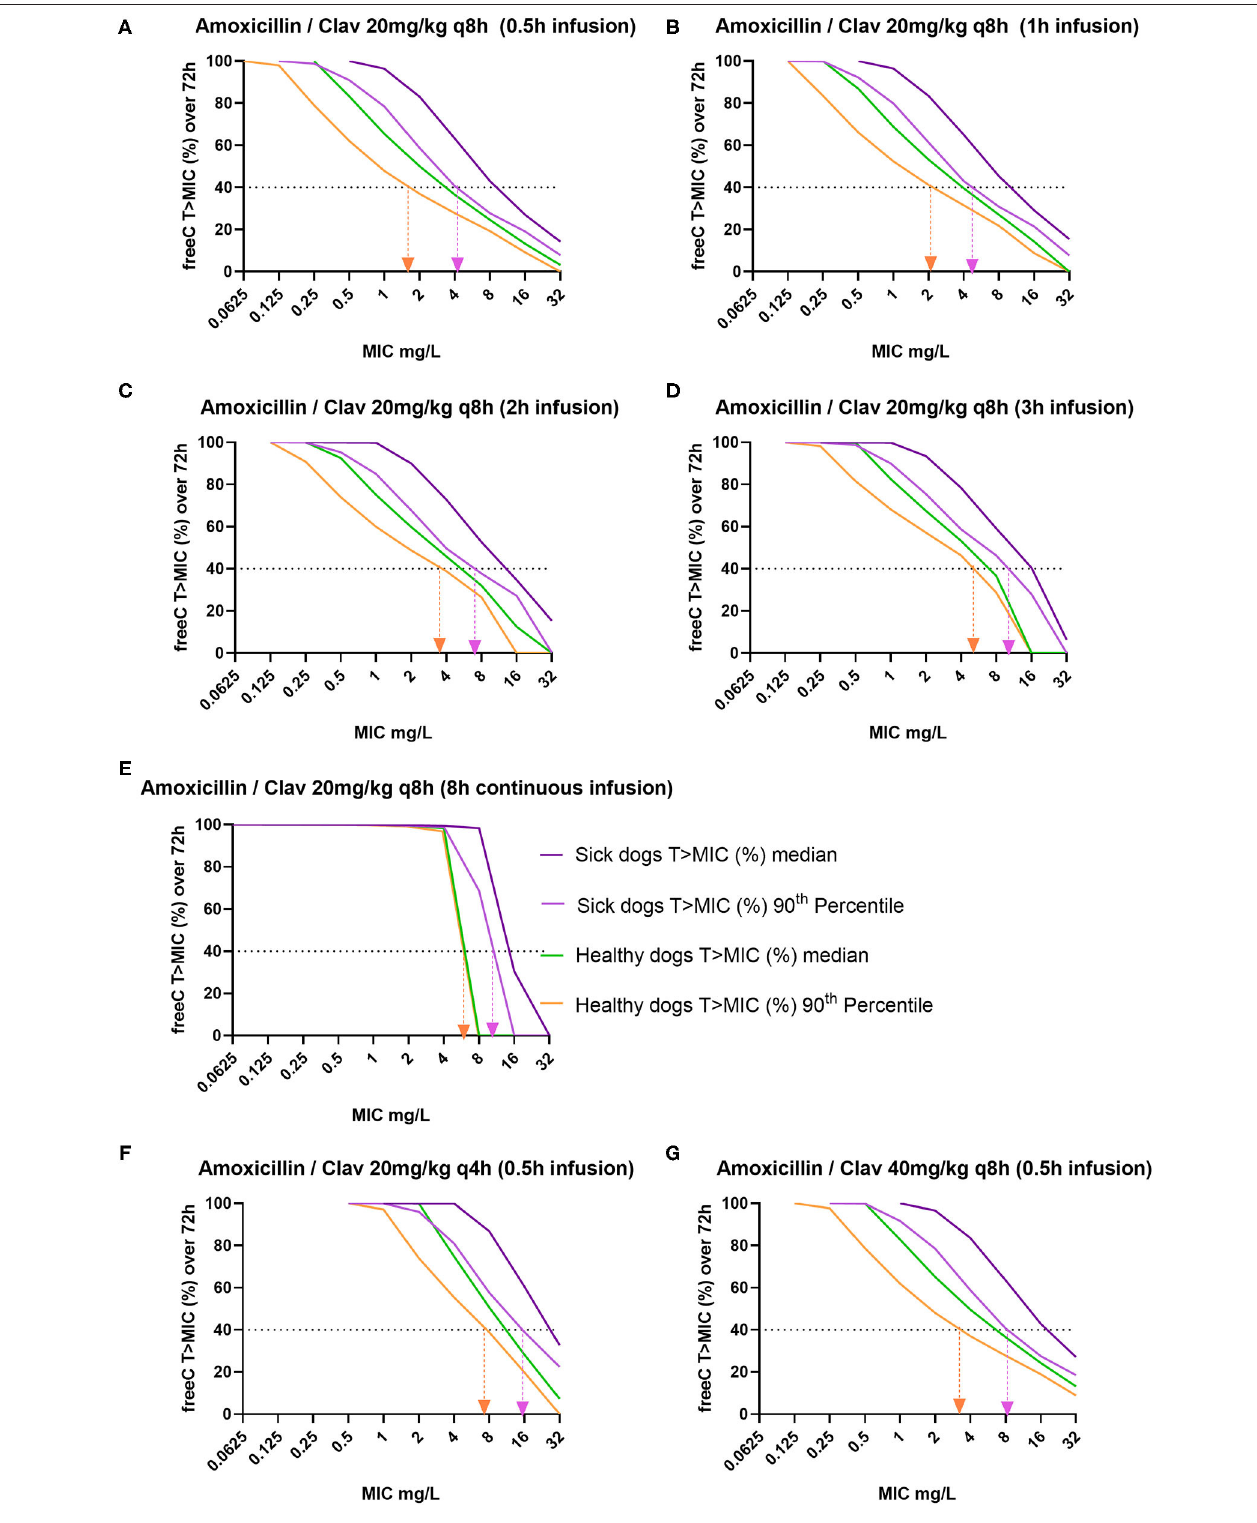
FIGURE 3 | Percentage of time (within a 72-h dosing interval) for which free plasma concentrations exceeds minimum inhibitory concentration (MIC) (fT > MIC%) for the median and the 90th percentile of healthy and sick dogs ( n = 1,000 simulations). Healthy dogs’ percentiles, represented by green (50th) and orange lines